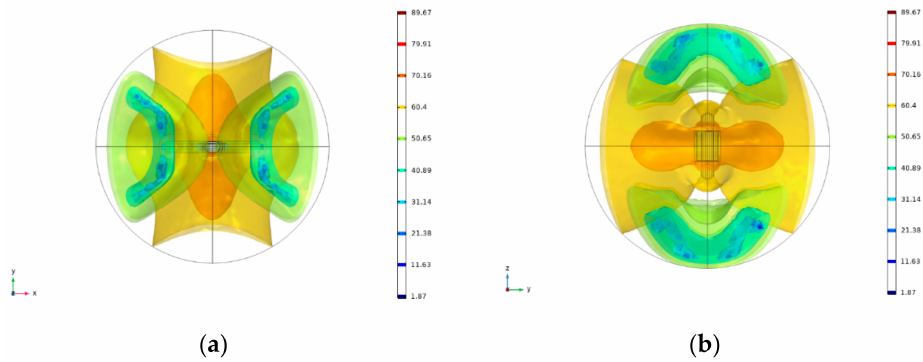
Figure 11. Sound power level distribution viewed from ( a ) top and ( b )